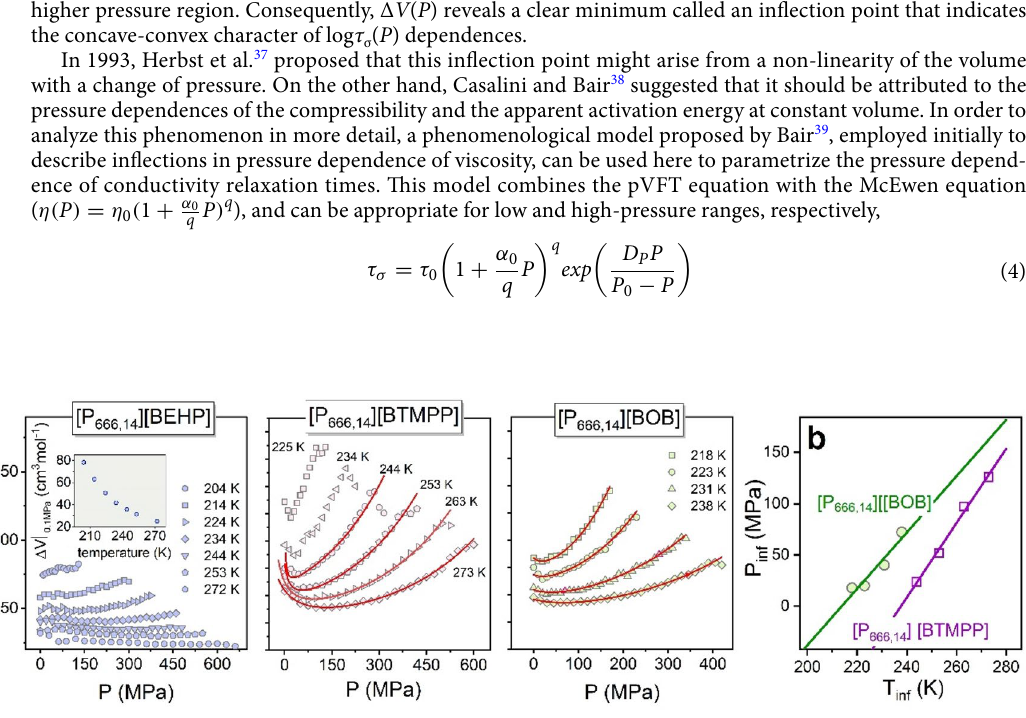
Figure 6. ( a ) Pressure dependences of activation volume for [P 666,14 ][BEHP] [P 666,14 ][BTMPP] and [P 666,14 ] [BOB]. The lines are fits according to Eq. (4). In the inset, the temperature dependence of activation volume of [P 666,14 ][BEHP] at ambient pressure is shown. ( b ) Temperature dependence of inflection pressure for [P 666,14 ] [BTMPP] and [P 666,14 ][BOB]. Solid lines are linear fits, extrapolating to the inflection temperature at 0.1